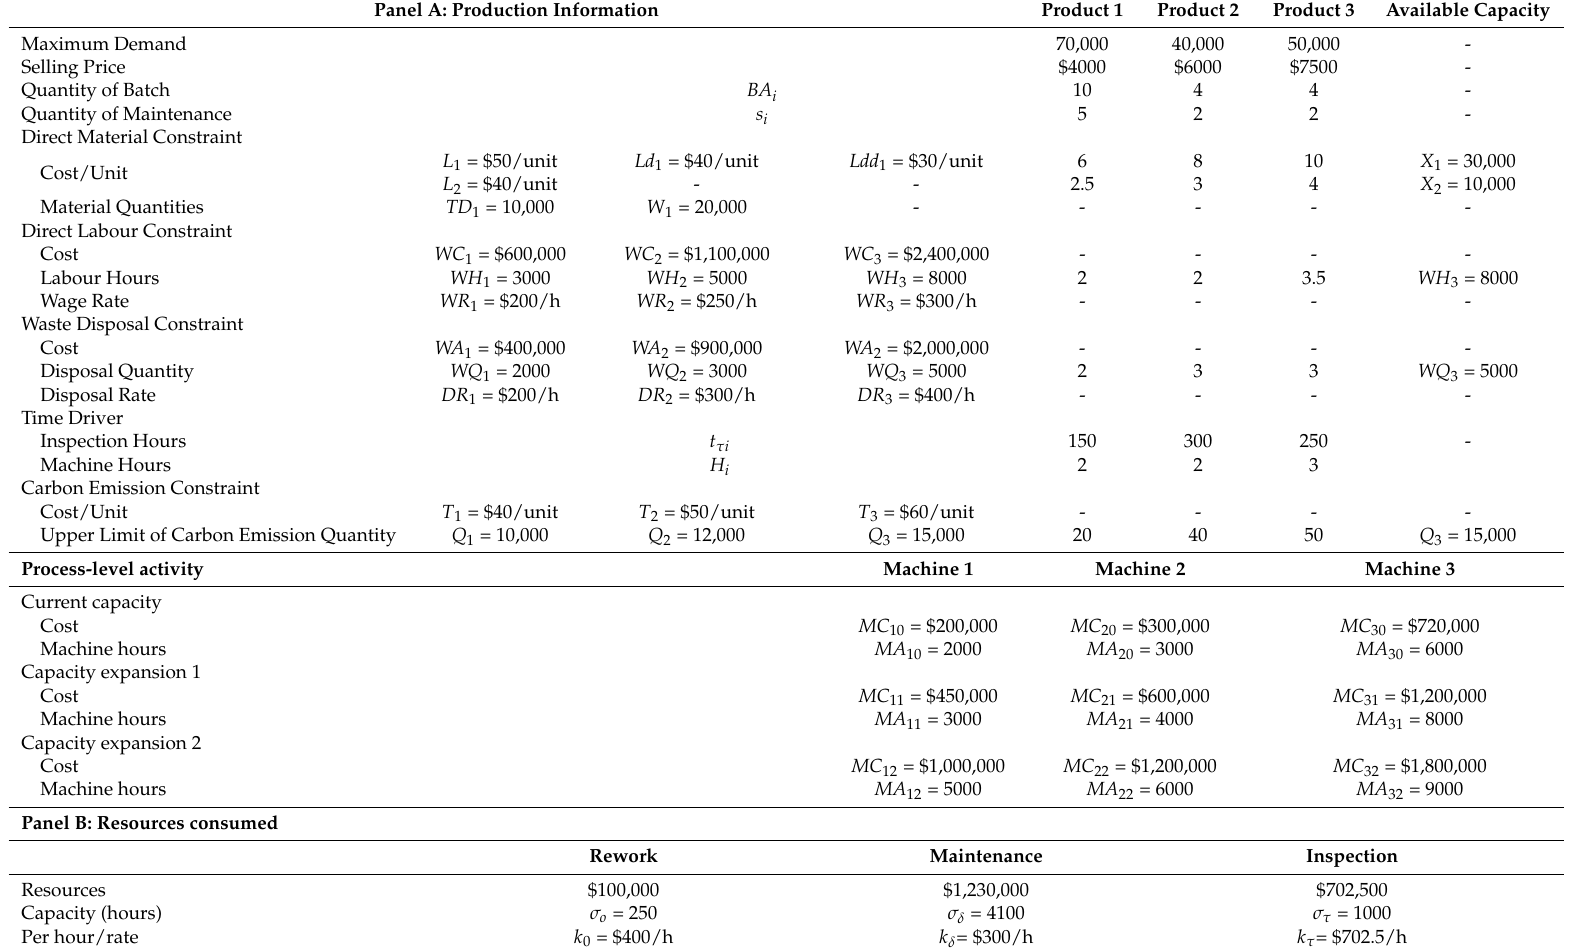
Table 2. Data for the numerical